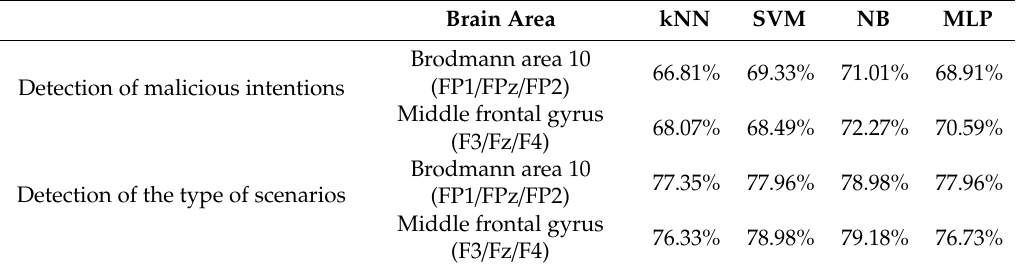
Table 6. Average classification accuracy using specific brain areas with